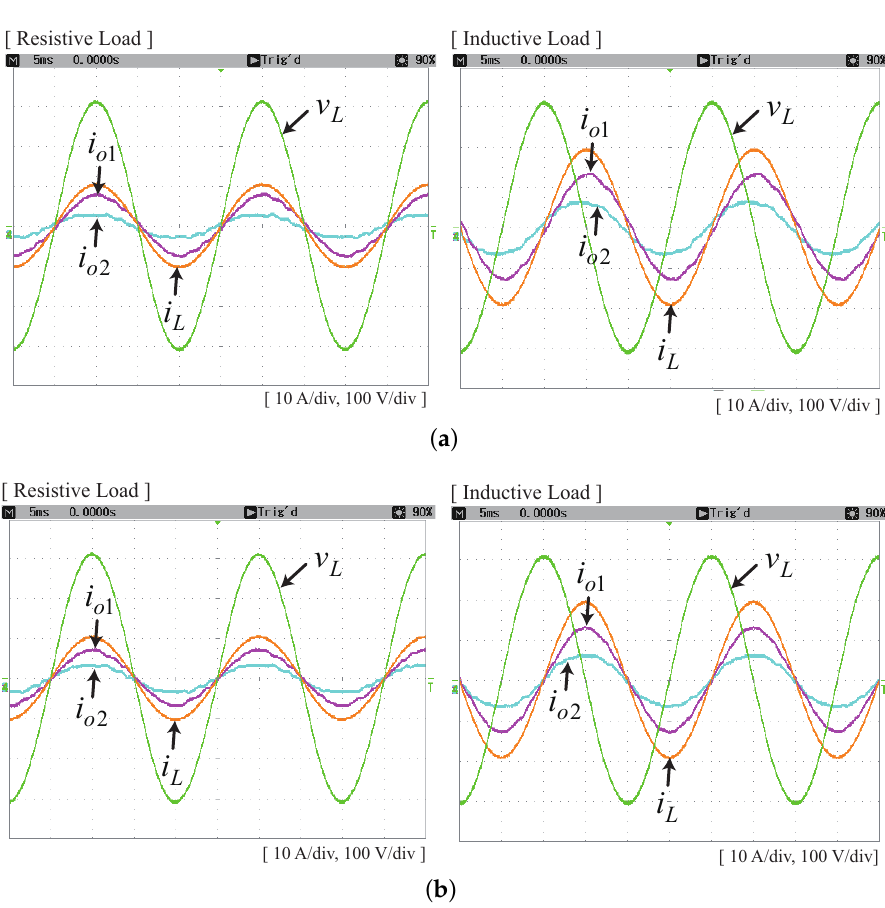
Figure 9. Controlled local AC bus voltage and output current waveforms in a resistive and inductive load condition: ( a ) conventional droop method; ( b ) proposed active impedance control.